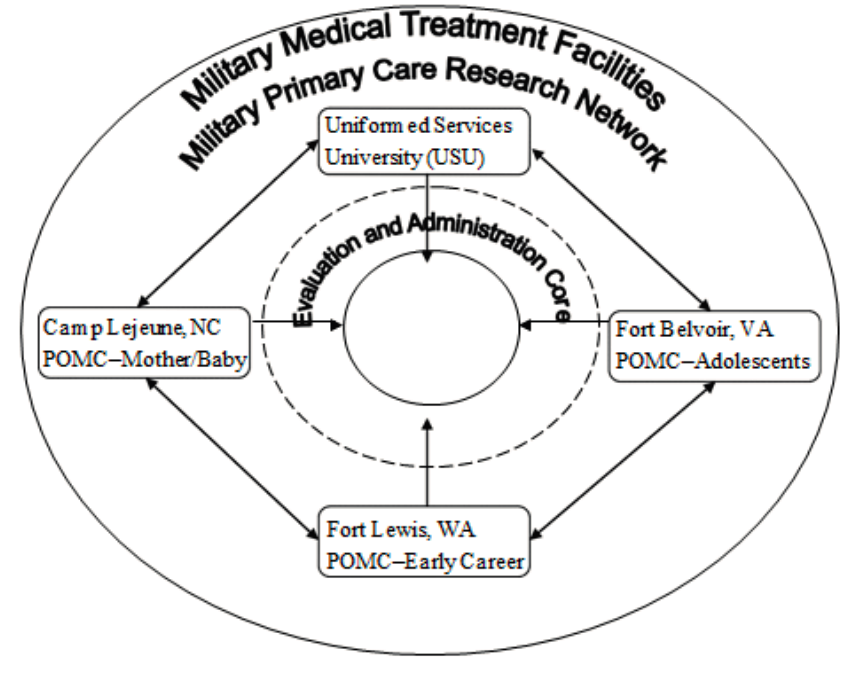
Figure 1. POMC conceptual